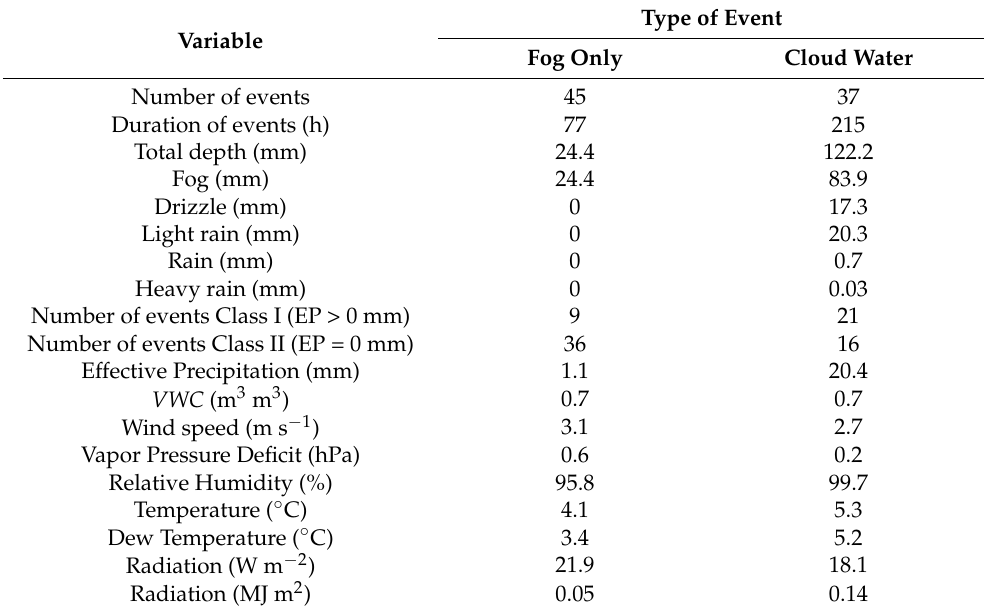
EP = effective precipitation. VWC = volumetric water